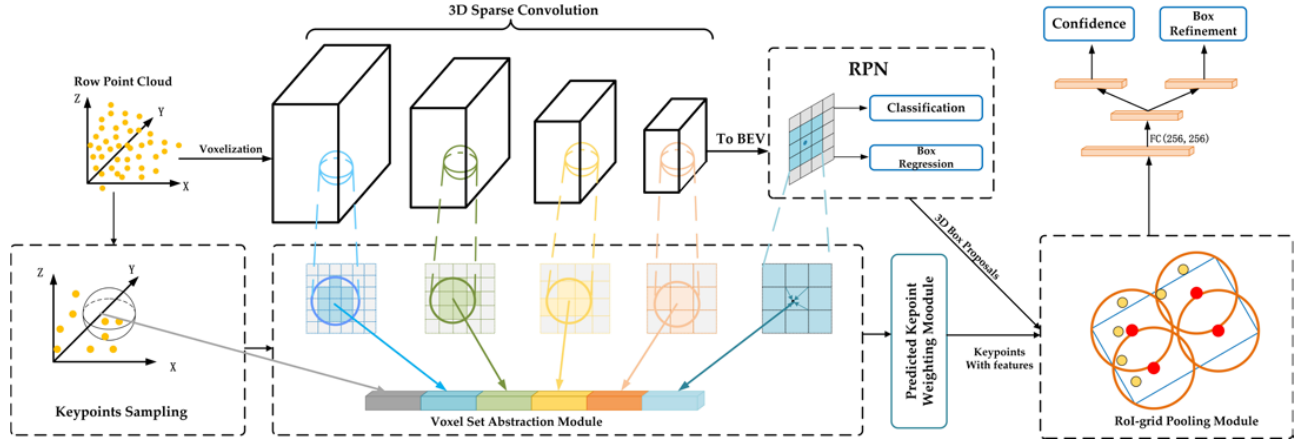
Figure 4. PV-RCNN network structure.